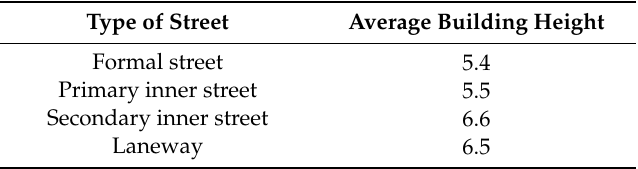
Table 2. Average building heights in each type of street.